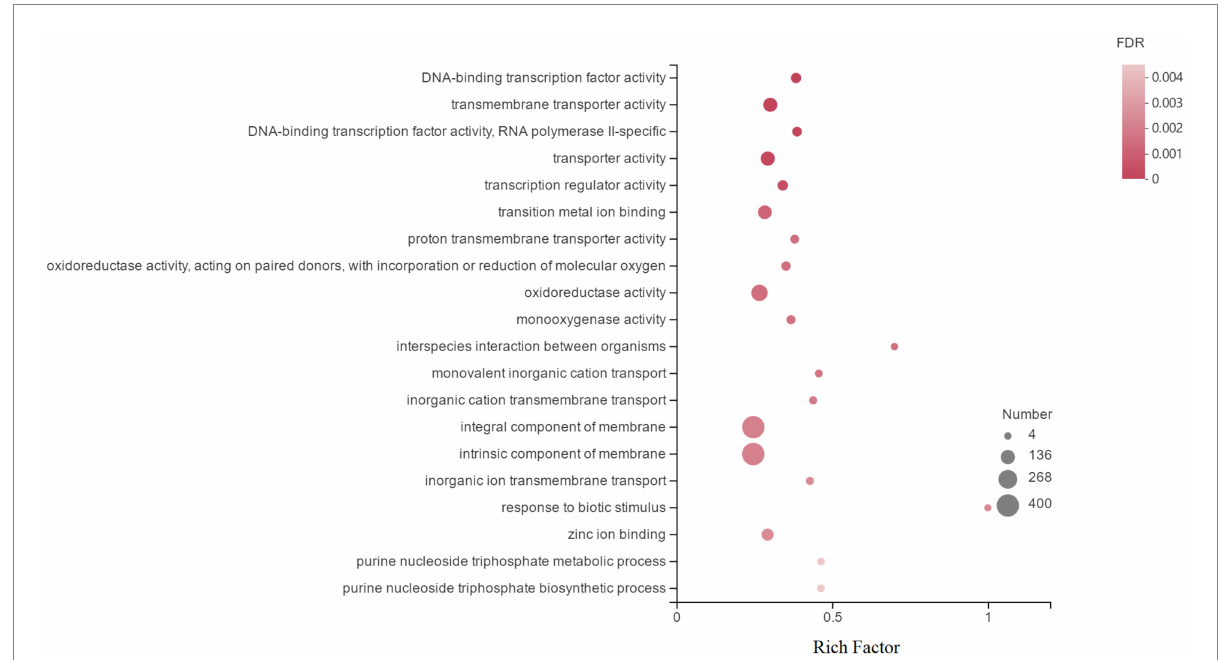
FIGURE 4 Top 20 enriched GO terms associated with DEGs in response to Cd stress. (The vertical axis represents the GO Term, the horizontal axis represents the Rich factor [the ratio of the number of samples enriched in the GO term to the background number; a larger Rich factor indicates greater enrichment], the size of the dots indicates the number of genes/transcripts in the GO Term, and the color of the dots corresponds to the different. The color of the dots corresponds to different FDR ( p value corrected)